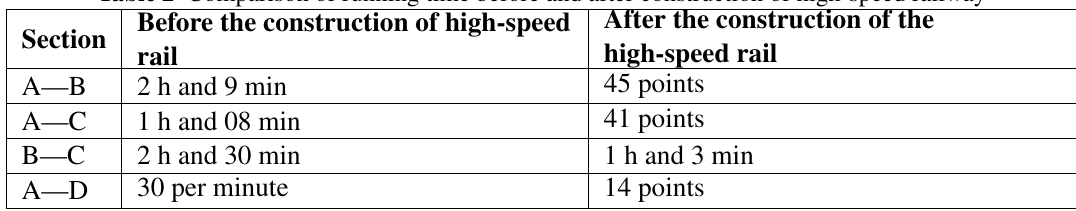
Table 2 Comparison of running time before and after construction of high-speed